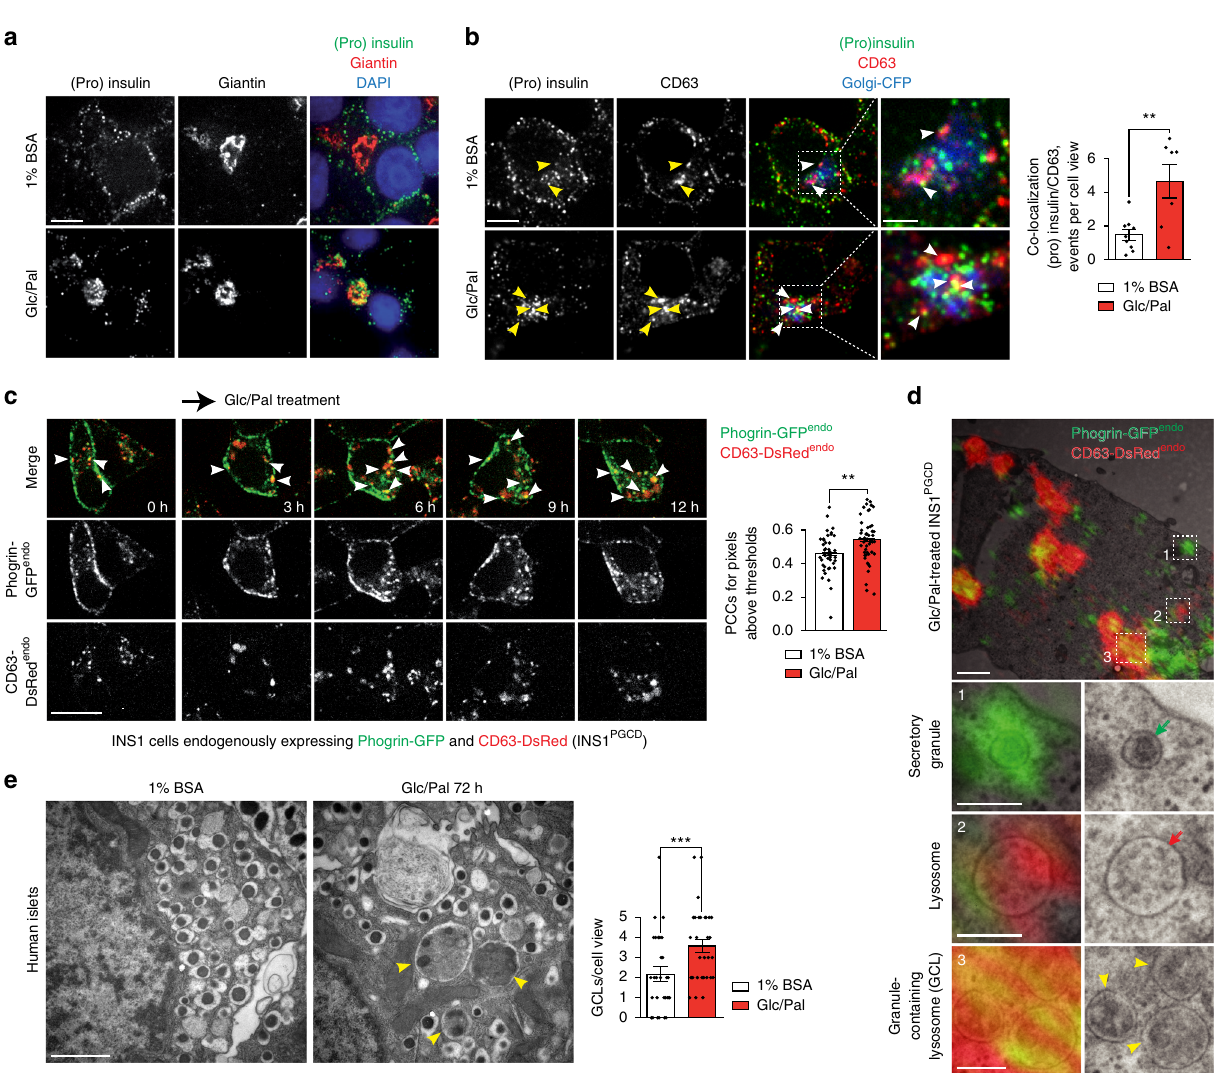
Fig. 1 Targeting of secretory granules to lysosomes in response to glucolipotoxicity in β cells. a Immuno fl uorescence (IF) of insulin + proinsulin ( “ (pro) insulin ” ) (green) and giantin (red) in INS1 cells treated with control (1% BSA, 11mM glucose, “ 1% BSA ” ) or glucolipotoxic (1% BSA, 33.3mM Glucose and 0.4mM Palmitate, “ Glc/Pal ” ) media for 20h. Nuclei were stained with DAPI. Scale bar, 5 μ m. b IF of (pro)insulin (green) and CD63 (red) in INS1 cells treated with 1% BSA or Glc/Pal media for 20h. Golgi-CFP was used to visualize the Golgi apparatus. Arrowheads point to (pro)insulin/CD63 co-localization. Scale bar, 5 μ m; for insets: 2 μ m. Quanti fi cation of co-localization events between (pro)insulin and CD63 per cell view. Fields from three independent experiments, N = 9; N = 11, n cells: 82 and 64, respectively; ** P < 0.01, two-tailed t -test. c Imaging of INS1 PGCD cells endogenously expressing Phogrin-GFP 1%BSA Glc/Pal (Phogrin-GFP endo ) and CD63-DsRed (CD63-DsRed endo ) treated with Glc/Pal for indicated time periods. Arrowheads point to Phogrin-GFP endo /CD63- DsRed endo co-localization. Scale bar, 20 μ m. Quanti fi cation of co-localization between CD63-DsRed endo and Phogrin-GFP endo using Pearson ’ s correlation. N = 42; N = 50 from three independent experiments; ** P <0.01, two-tailed t -test. d Correlative light and electron microscopy analysis of INS1 PGCD 1%BSA Glc/Pal cells treated with Glc/Pal for 20h. Yellow arrowheads point to granule-containing lysosomes (GCLs). Green and red arrows point to a secretory granule and a lysosome respectively. Scale bar, 1 μ m; for insets: 0.3 μ m. e Electron microscopy analysis of β cells in human islets treated with 1%BSA or Glc/Pal media for 72h. Yellow arrowheads point to GCLs. Scale bar, 1 μ m. Quanti fi cation of GCLs per cell view. N 1%BSA = 29; N Glc/Pal = 31 from three independent experiments; *** P <0.001, two-tailed t -test. In b , c , e data are shown as mean ±SEM, source data are provided as a Source Data fi